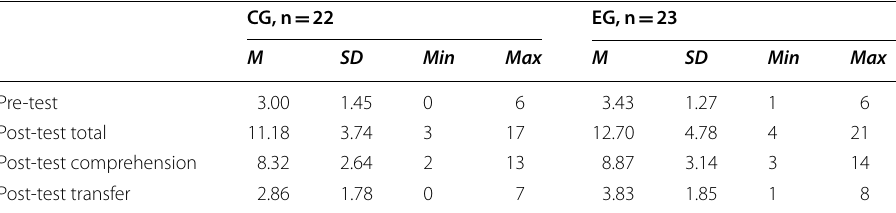
Table 2 Scores for the pre-test and post-test